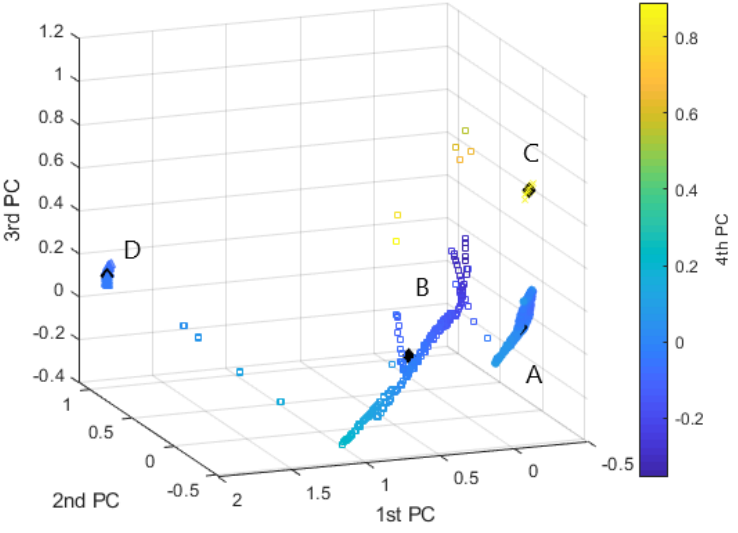
Figure 13. SC method with pairwise constrains. Clustering representation in the principal components scatterplot: Clust.A—“ ◦ ”, Clust.B—“ (cid:3) ”, Clust.C—“ x ”, Clust.D—“ (cid:52) ” (SC, K = 4).